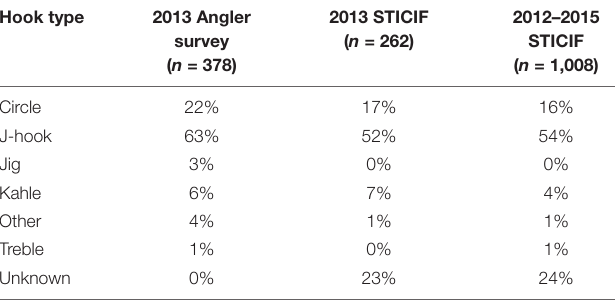
TABLE 1 | Hook type used by recreational anglers during the 2013 Angler Survey and 2012–2015 sea turtle incidental captures. Hook type